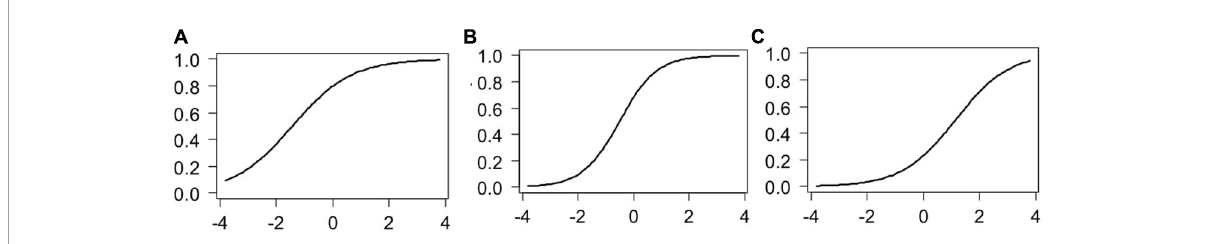
FIGURE4 Examples of item characteristic curves (ICCs) in items concerning mathematics. (A) ICC of Item 20 “When I learned mathematics, I checked whether answers were correct after solving.” (B) ICC of Item 18 “When I learned mathematics, I tried again to solve the problems that I had failed to solve.” (C) ICC of Item 23 “When learning mathematics, to prevent failure, I wrote points for attention in my notebook.”